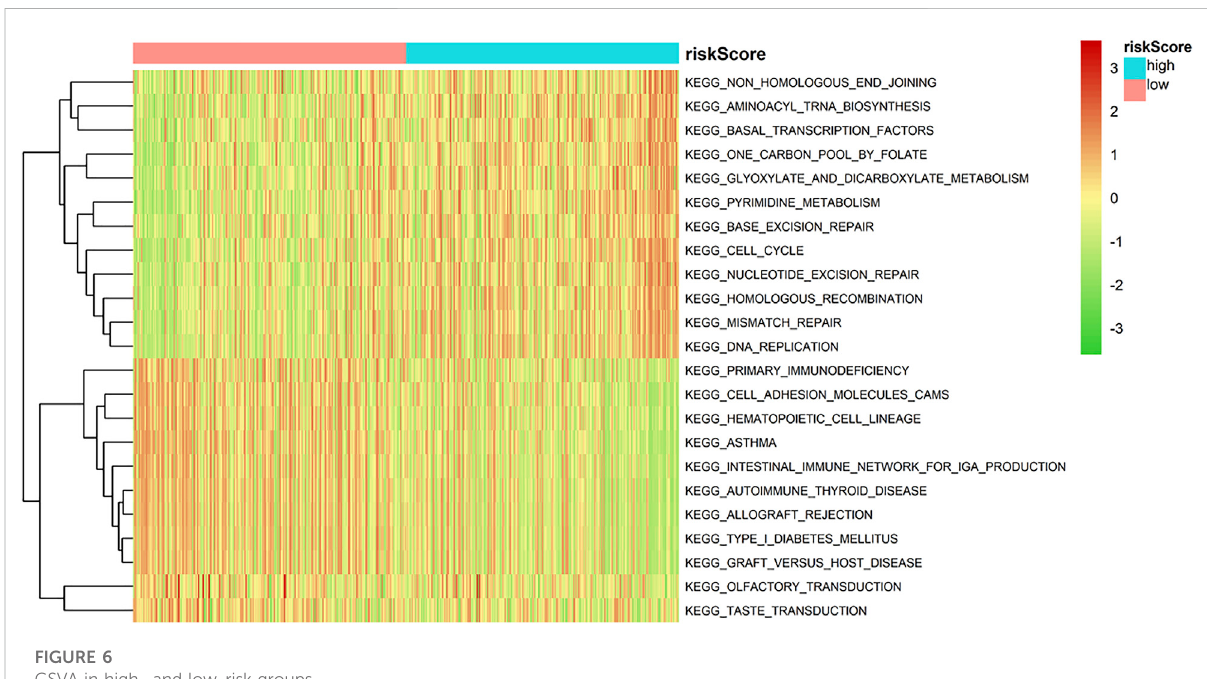
FIGURE 6 GSVA in high- and low-risk